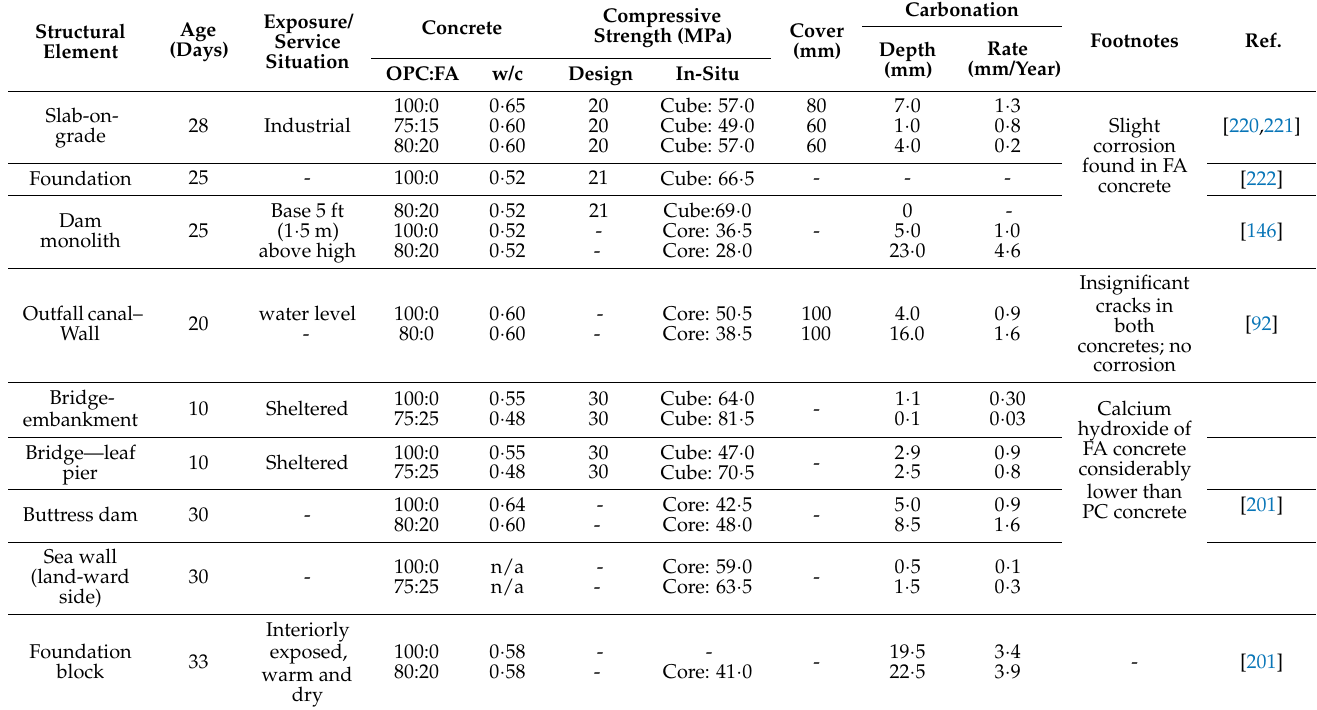
Table 10. Review on field measurement data of concrete produced with cement and FA.